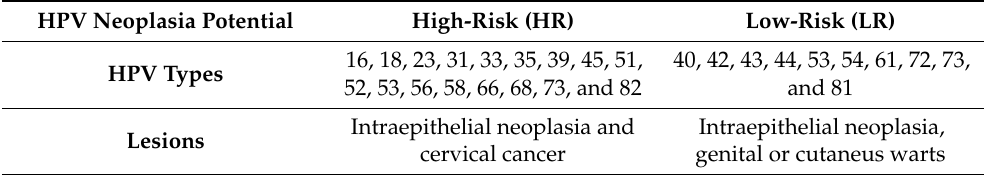
Table 1. HPV types and associated lesions.